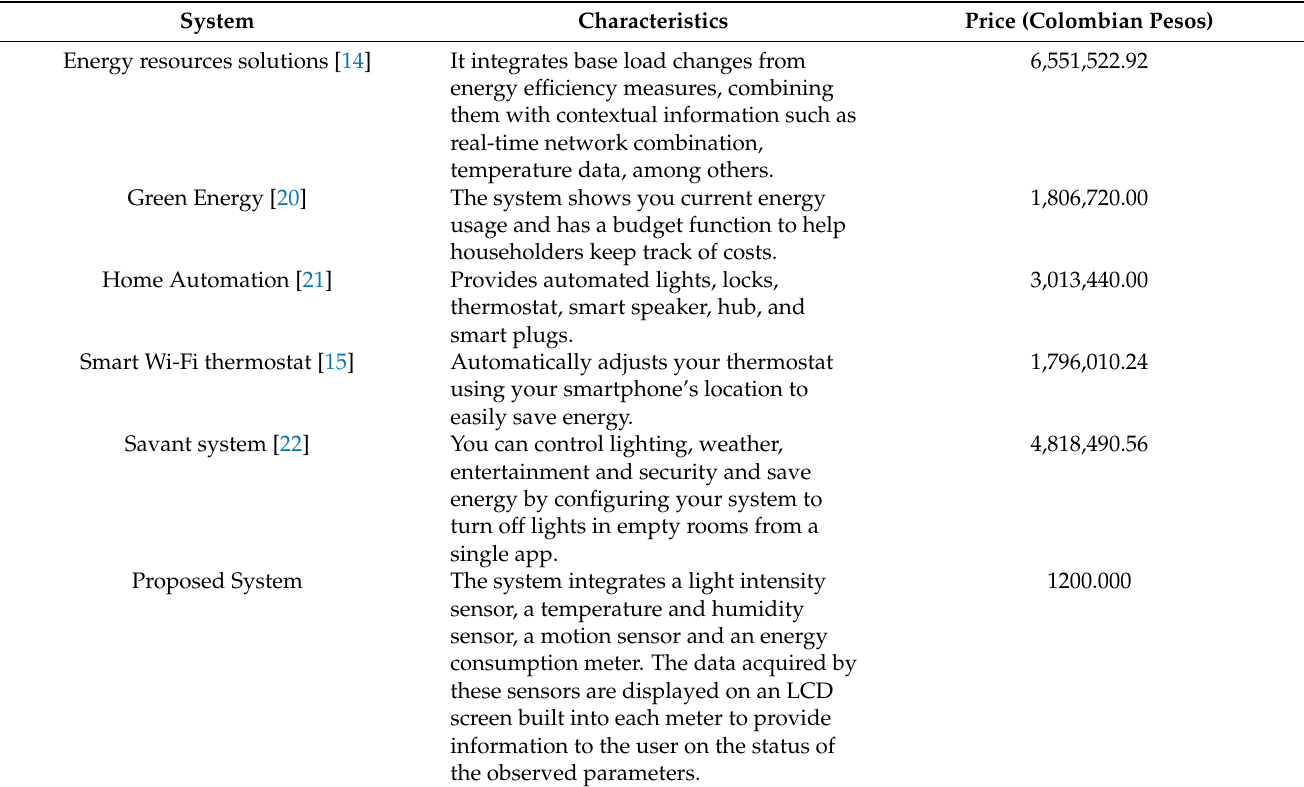
Table 12. Comparison of the proposed HEMS with commercial